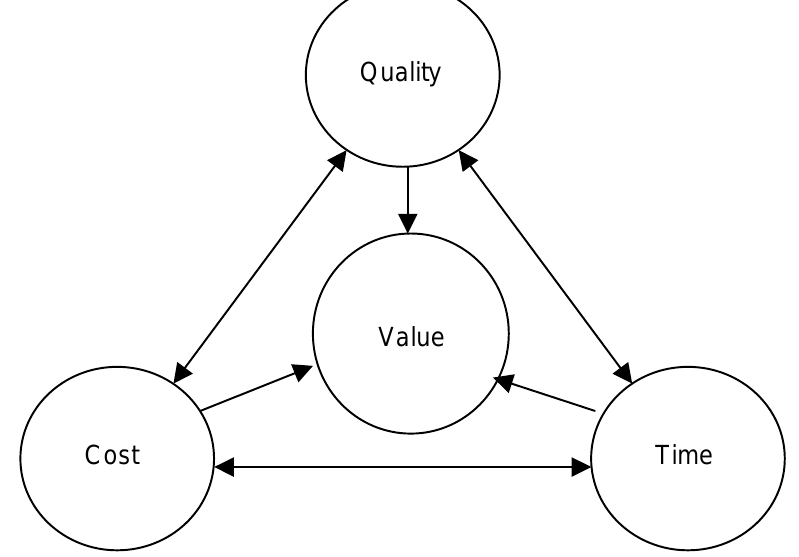
Figure 1: Cost-time-quality: the value